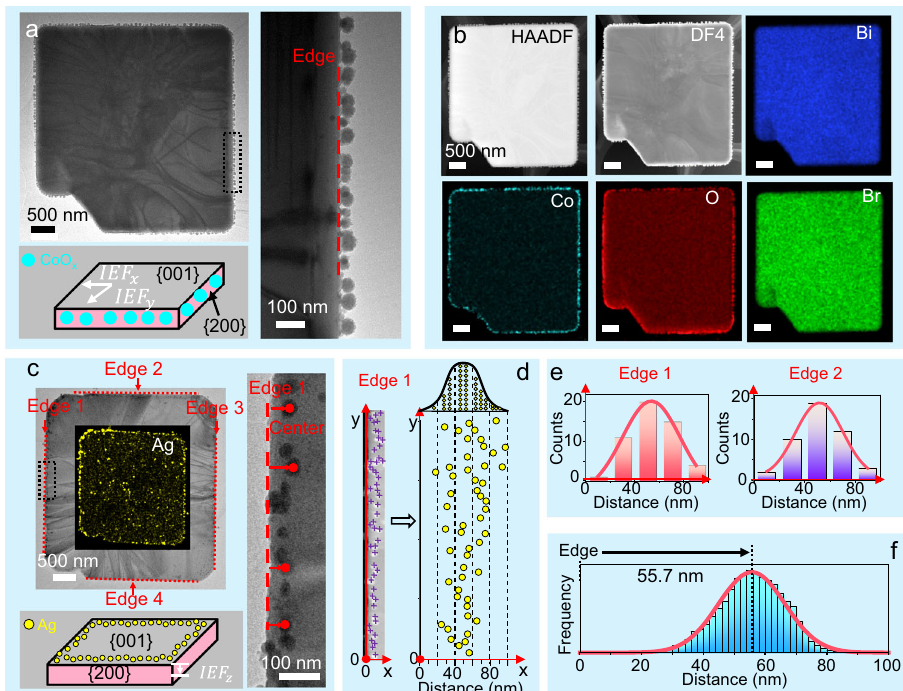
Fig. 2 Anisotropic charge separation behavior. a Low magni fi ed, expanded TEM images and schematic illustration indicating CoO x nanoparticles are dominantly photo-deposited on the side faces of a BiOBr platelet, as evidenced by the EDS maps in b , c Overview image and enlarged TEM image showing the photo-deposition of Ag nanoparticles on the (001) basal facets, with a schematic diagram given in the bottom left panel (inset: EDS map). d Left panel: HAADF image recorded at Edge 1 of c showing the aggregation of Ag nanoparticles in a line pattern. The centers of Ag nanoparticles are marked by purple crosses. Right panel: Their positions are plotted in a coordinate system. e Statistical histograms of the distances from the centers of Ag nanoparticles to edge 1 or edge 2, which can be described by a Gaussian pro fi le. f Statistical analysis of the spatial distribution of Ag nanoparticles with respect to the platelet edges after counting more than 50 individual BiOBr platelets from multiple TEM images. Source data are provided as a Source Data fi (Fig. 1c, d and Supplementary Fig. 1). Selected-area electron dif- fraction (SAED) (inset of Fig. 1d) con fi rms that the platelets are single crystalline. Since the electron beam direction is perpendicular to their basal planes, the basal facets are ascribed to be (001) planes. High-resolution electron microscopy (HREM) imaging was per- formed at the platelet edge (Fig. 1e), demonstrating that the side faces are terminated by (200) and (020) planes. These results combined indicate that BiOBr crystals are enclosed by two large {001} facets as the basal planes and four identical {200} planes being the side faces, as illustrated in Fig. 1f.